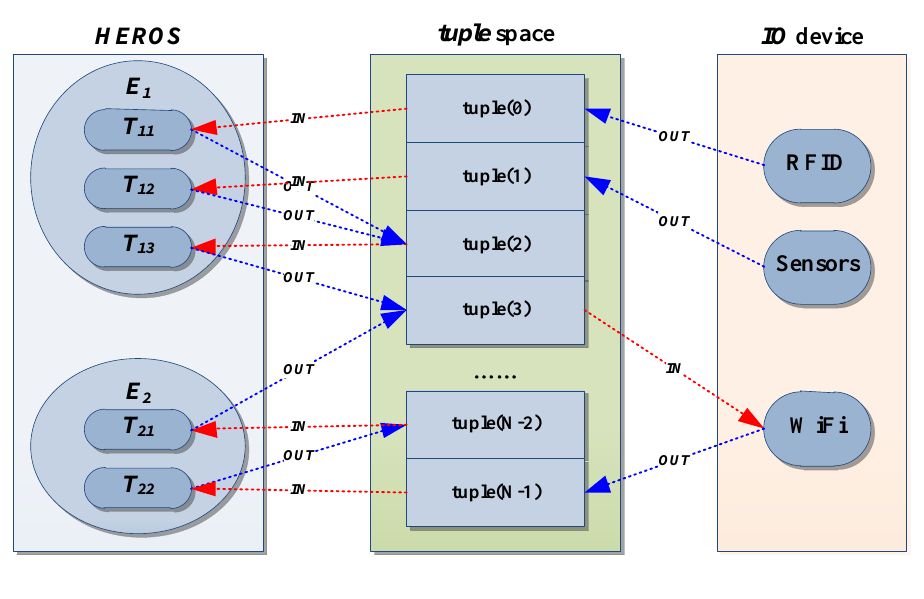
Figure 3. Schematic diagram of HEROS.